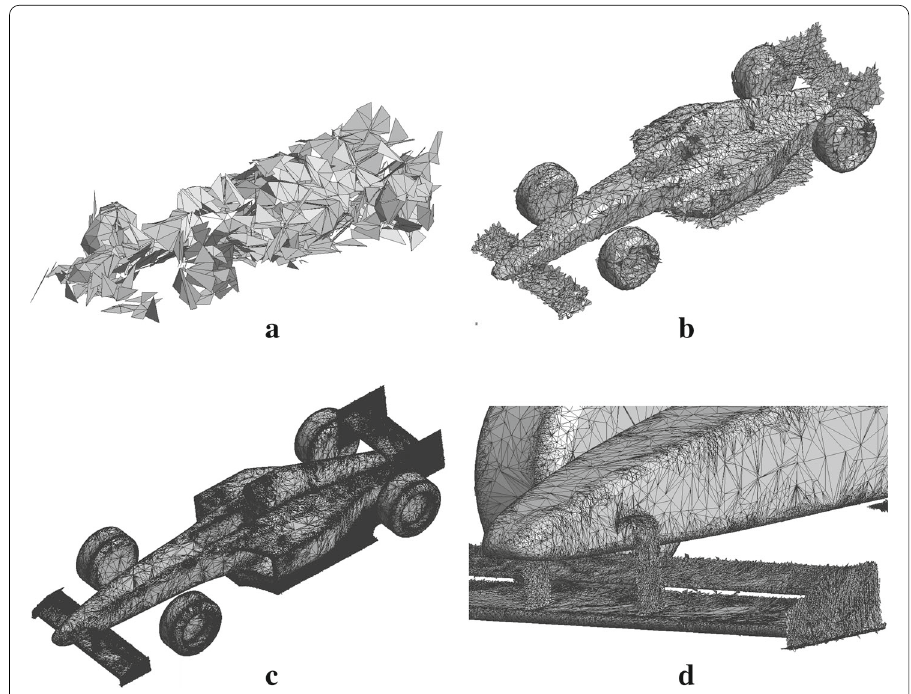
Fig. 39 Surface approximation of racing car with different refinements of the background mesh. a No refinement (4 . 0 e 4 fluid elements). b 2 levels of refinement (9 . 5 e 4 fluid elements). c 5 levels of refinement (1 . 6 e 6 fluid elements). d Close-up after last